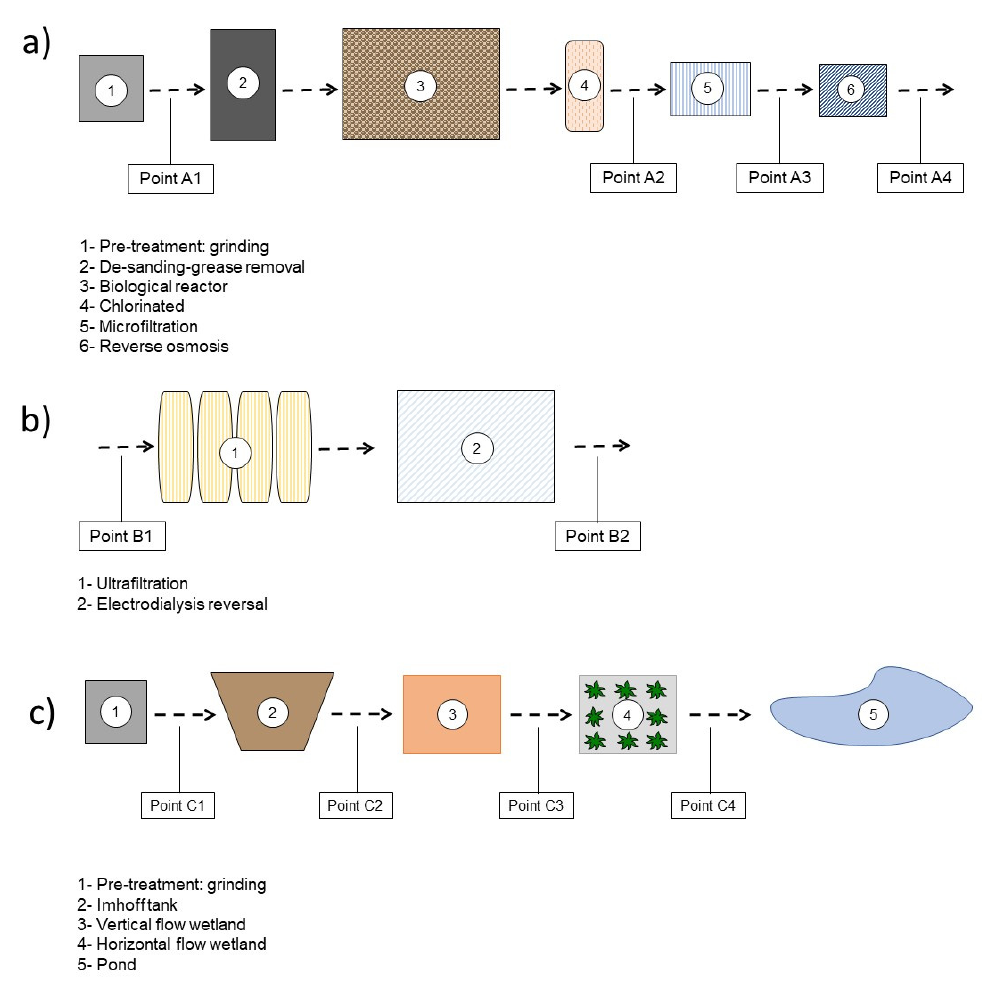
Figure 1. Layout of wastewater treatment plants (WWTPs) surveyed. ( a ) Conventional Wastewater Treatment Plant 1 (C-WWTP1); ( b ) Conventional Wastewater Treatment Plant 2 (C-WWTP2); ( c ) Natural Wastewater Treatment Plant (N-WWTP). Figure adapted from [19].